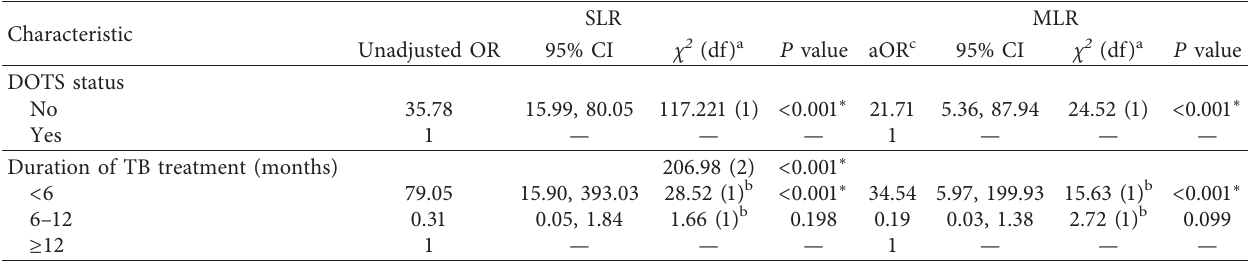
Table 4: Significant determinant factors of TB treatment outcomes in patients with TB-HIV in Kuala Lumpur, the final model (total patients, n �